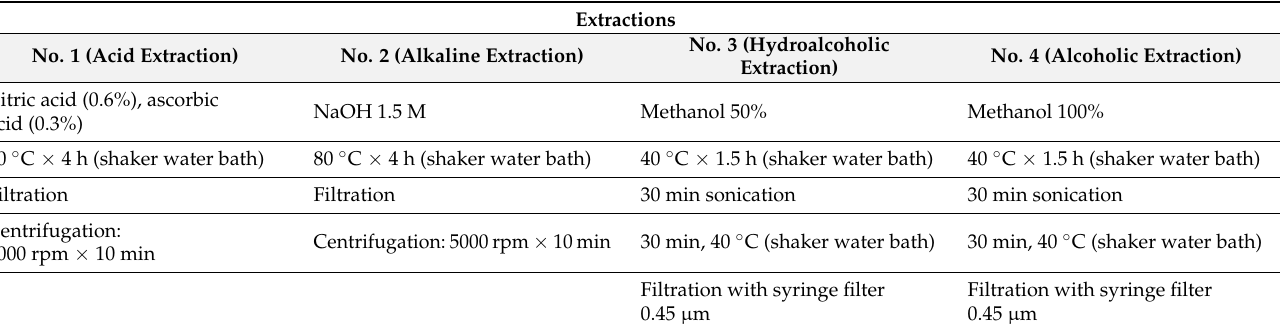
Table 1. Extraction